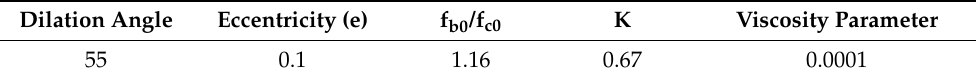
Table 1. Plasticity parameters utilized in ABAQUS simulations for CDP.